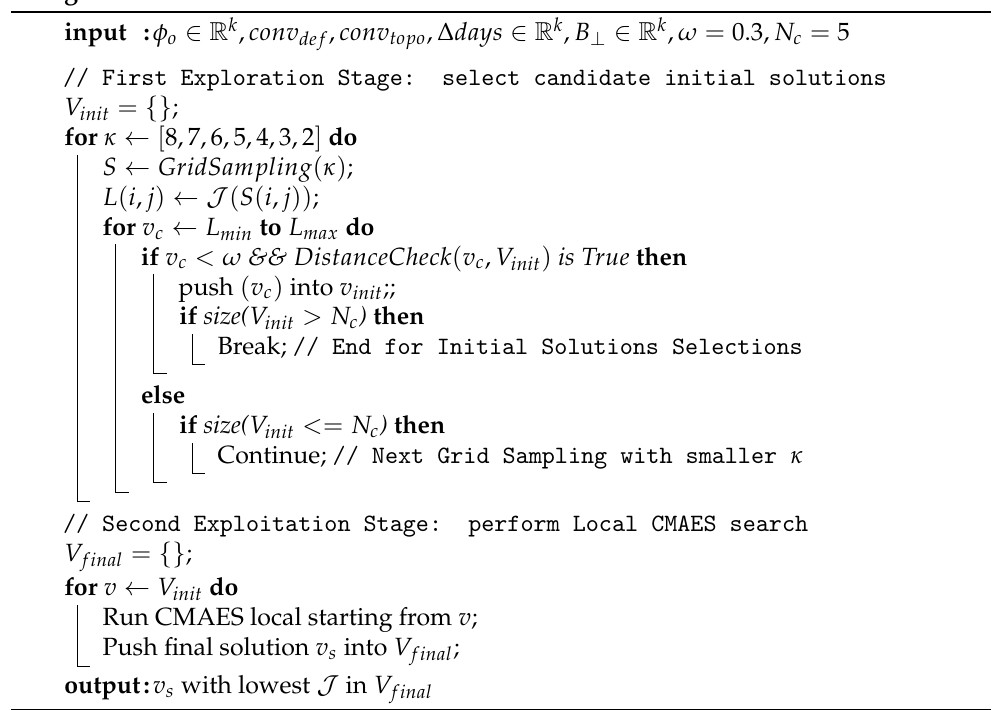
Algorithm 1: IGS-CMAES for deformation rate and DEM error